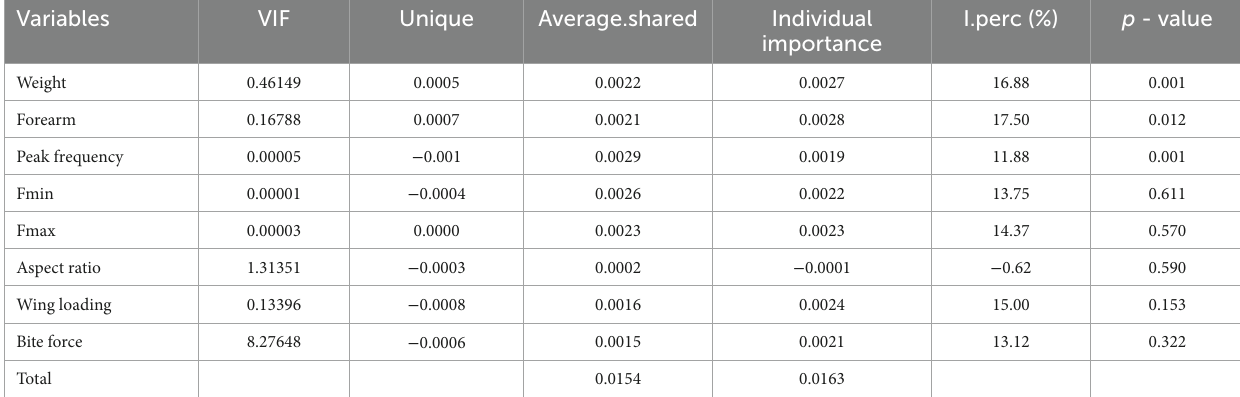
TABLE 4 Hierarchical partitioning of the relative importance of each influencing factor relative to the total explanatory variables. Variables VIF Unique